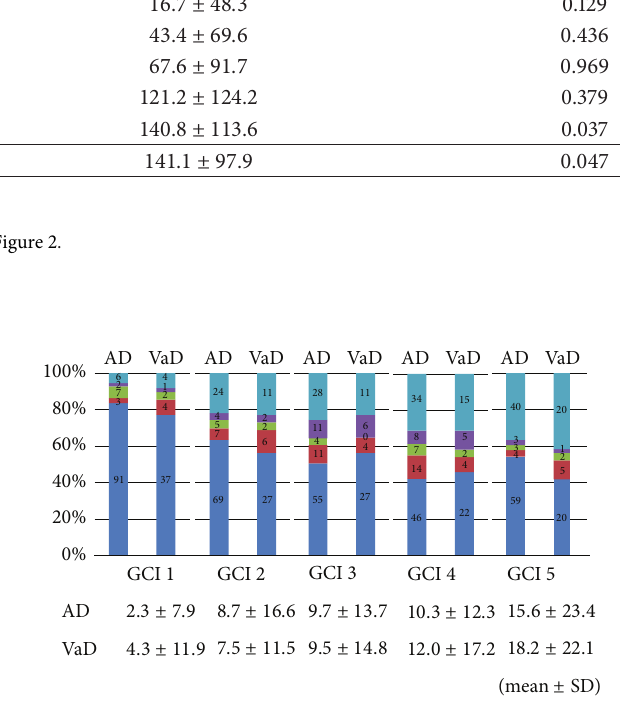
Figure 2: Percentages for each time period (0–3 months/4–6 months/7–9 months/10–12 months/over 13 months) that AD and VaD patients spent at each GCI stage. Mean duration for each GCI stage (month). AD: Alzheimer’s disease; VaD: vascular dementia. Number in the figure is the number of the patients in each time period. As the GCI stage increased, patients in both groups spent a longer duration in each of the subsequent periods. However, there was no significant difference between the two groups in the duration of any of the GCI